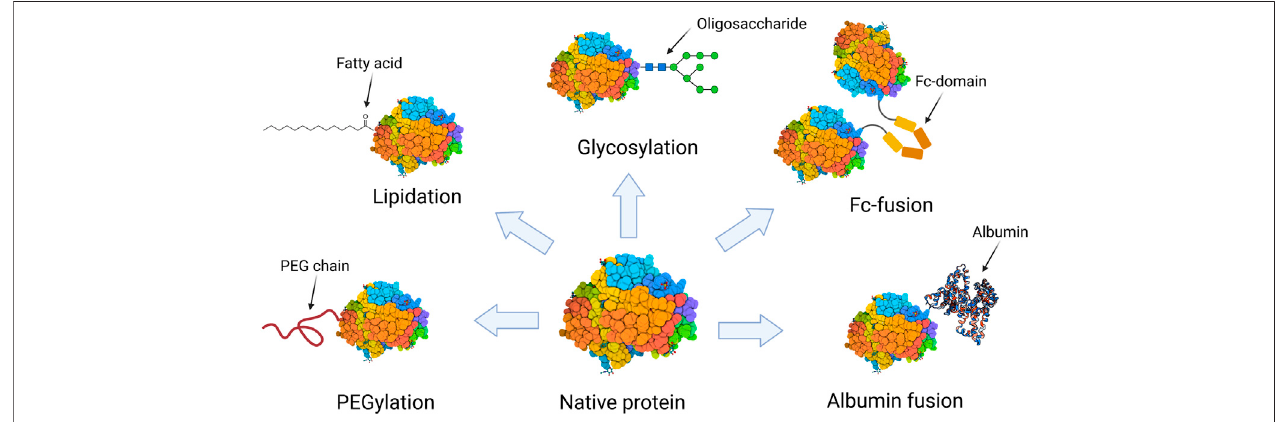
FIGURE 1 | Schematic representation of the protein modi fi cation approaches that are present by at least one biopharmaceutical on the market.